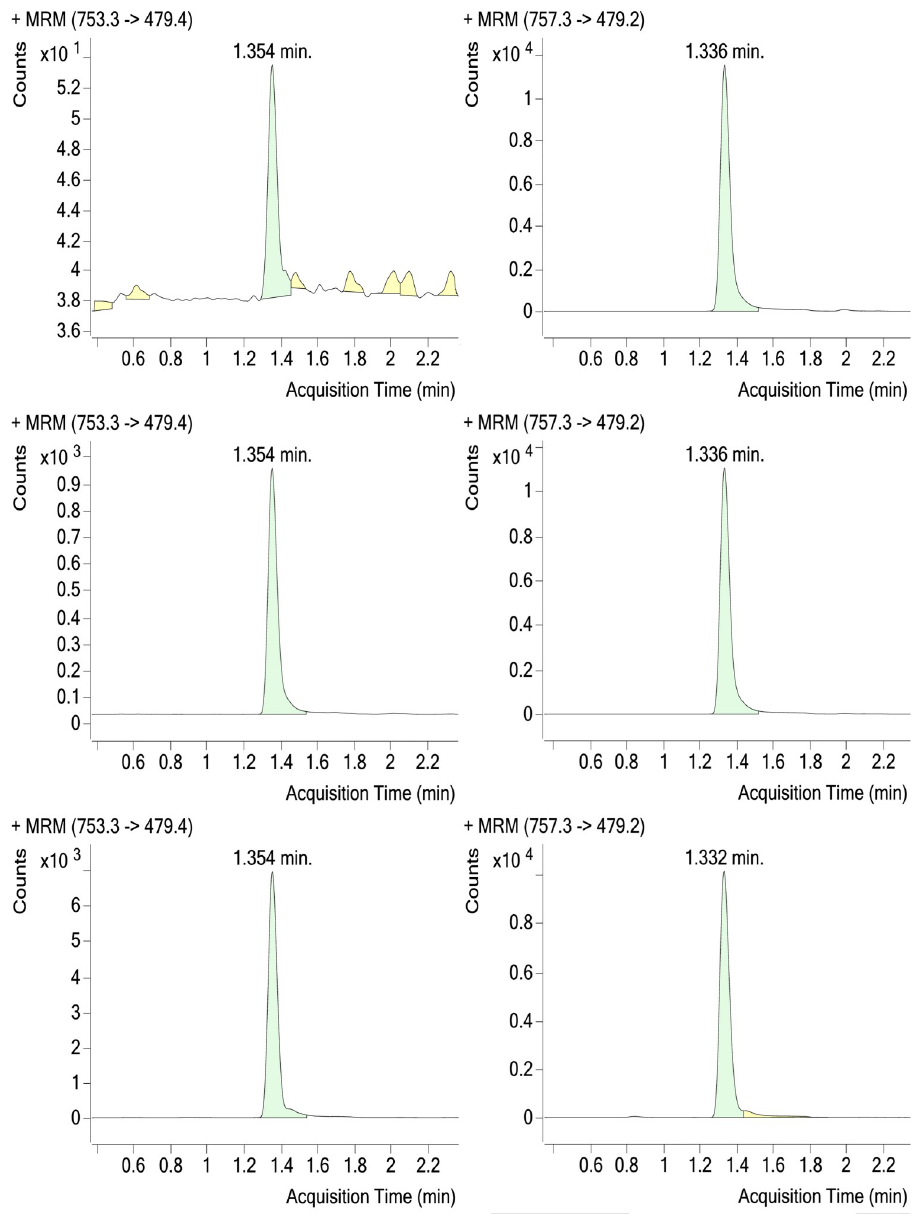
Fig 5. Chromatogram of M6 Blank (upper), LLOQ (middle), and a Treated Patient (lower) Plasma Samples, With Internal Standard (right). LLOQ, lower limit of quantitation; MRM, multiple reaction monitoring.